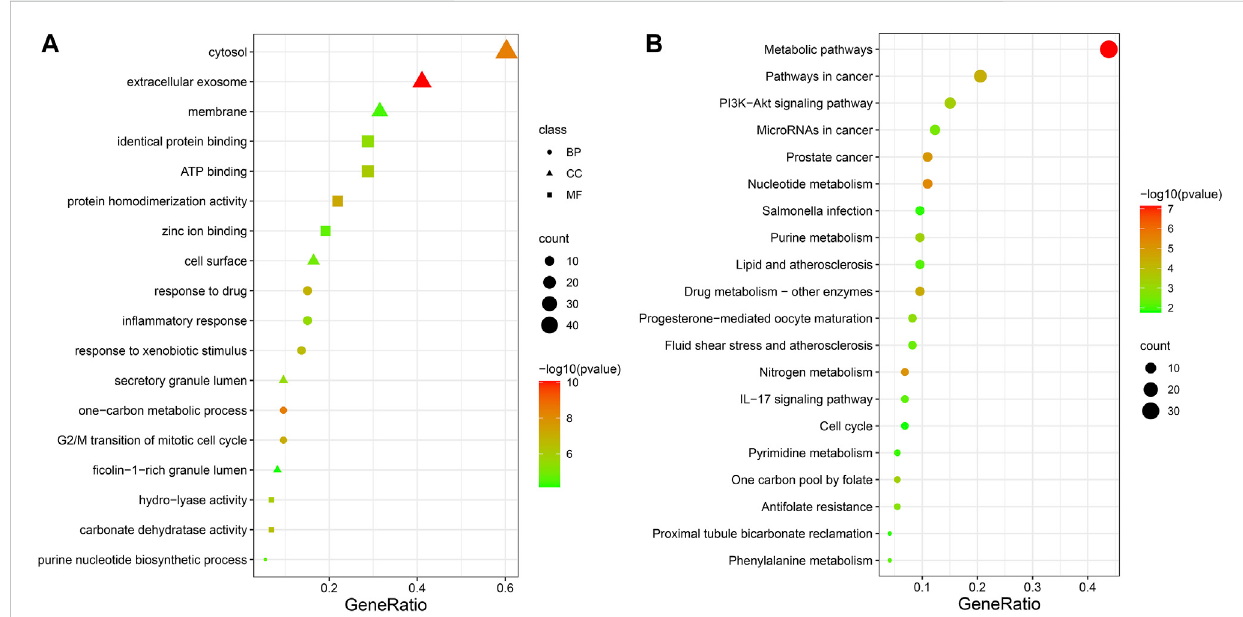
FIGURE 4 Bubble plot of enrichment analysis ( (A) . GO functional enrichment analysis of curcumin in colon cancer. (B) . KEGG pathway enrichment analysis of curcumin in colon